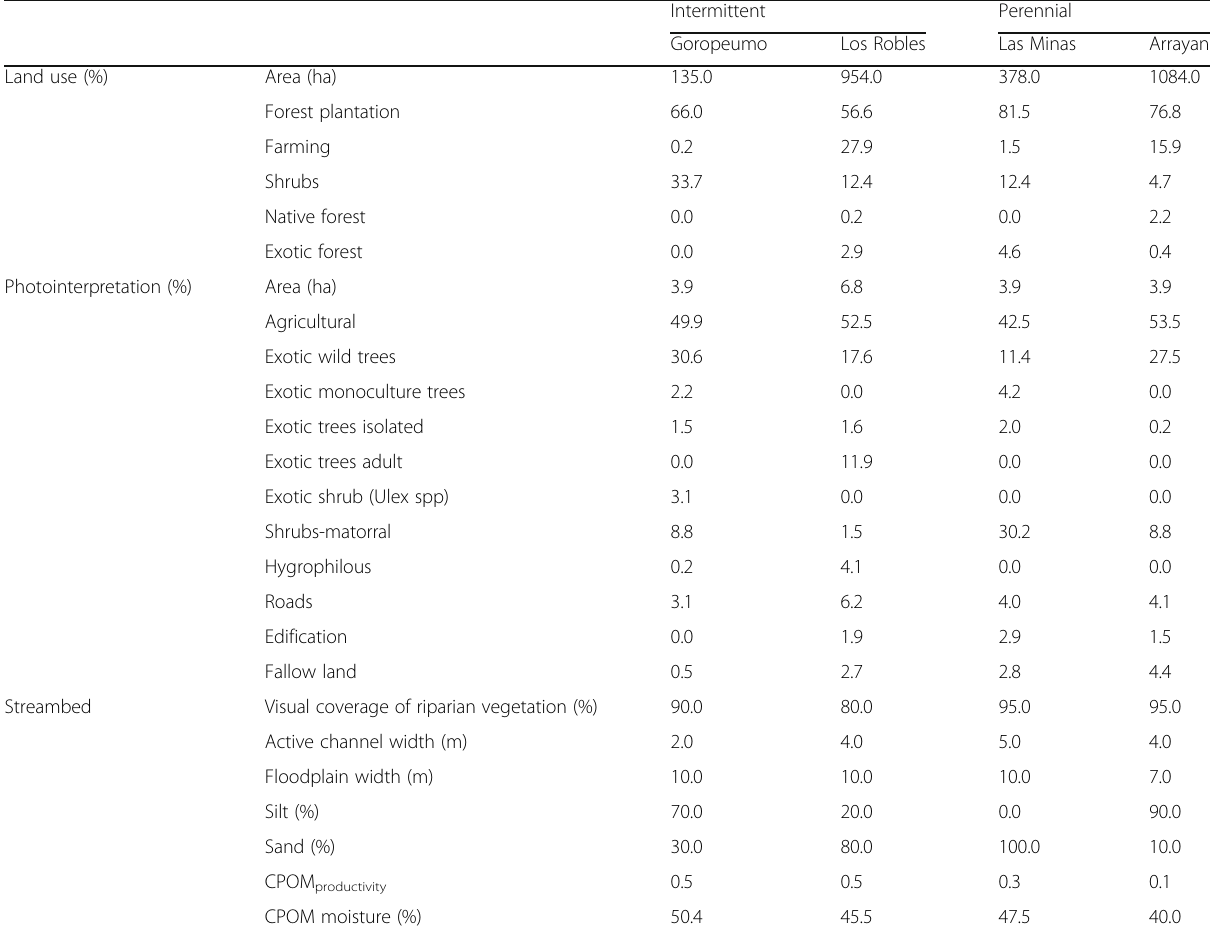
Table 1 Soil use of the microbasins, photointerpretation of the reach, including influence area, and characteristics of the studied riverbeds in the Lonquén river